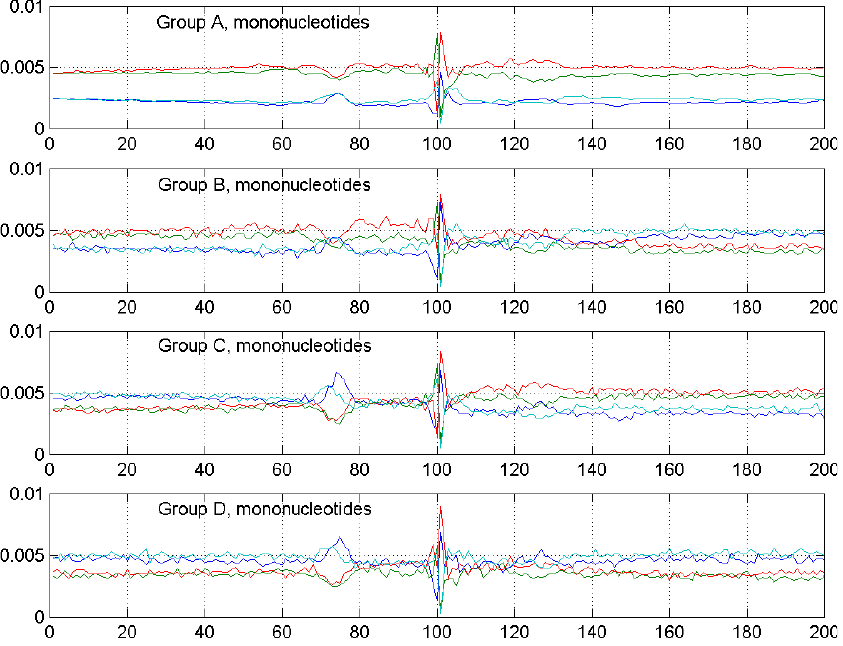
Figure 2. Distribution of Mononucleotides in Mouse Promoters in the Region Surrounding the TSS The nucleotides adenine, cytosine, guanine, and thymine are represented by blue, green, red, and light blue, respectively. The TSS types that are GC- poor upstream (C and D) show very characteristic enrichment in adenine and thymine nucleotides around [ (cid:2) 35, (cid:2) 20], suggesting a potential dominant influence of TATA box and similar AT-rich elements in transcription initiation in these types. In type B and A TSSs, this influence does not seem to be dominant, but the presence of such elements is suggested by a significant reduction of the GC content in the [ (cid:2) 35, (cid:2) 20] region. In principle, one could attempt to link the types of AT-rich upstream elements with initiating dinucleotides characteristic of different TSS types. DOI: 10.1371/journal.pgen.0020054.g002 (Figure S1); it also only gradually changes with a change of threshold for GC richness (Figure S1). These findings suggest robustness of our TSS classification.